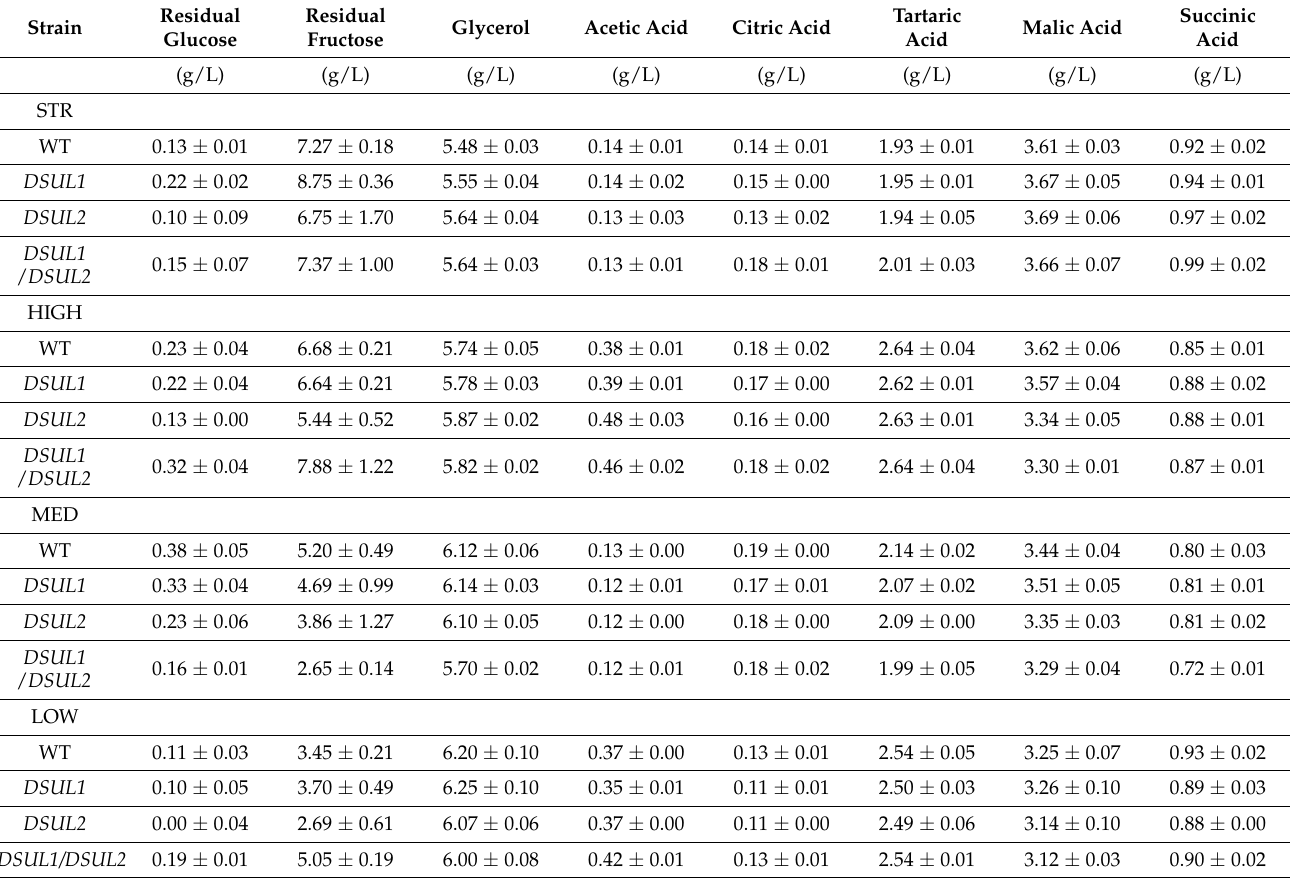
Table 1. Levels of relevant metabolites detected by HPLC assay (values are expressed as mean ± S.E., n =